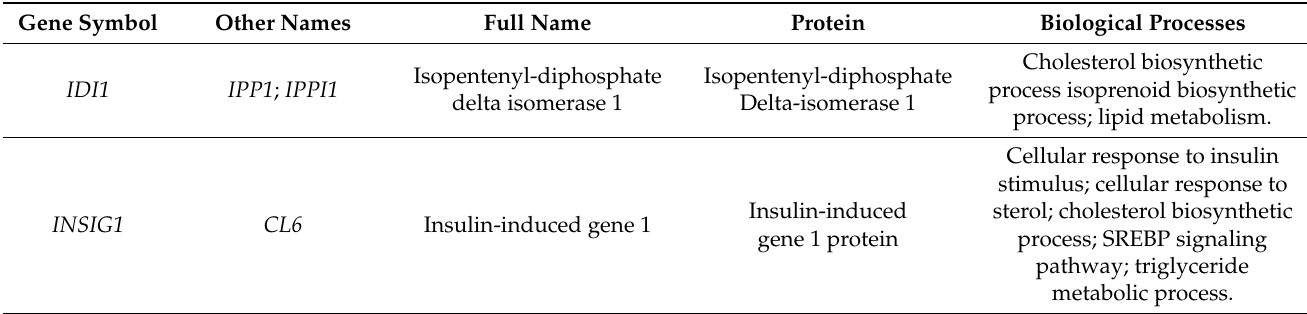
Table 6. Functional roles and general information of the down-regulated hub